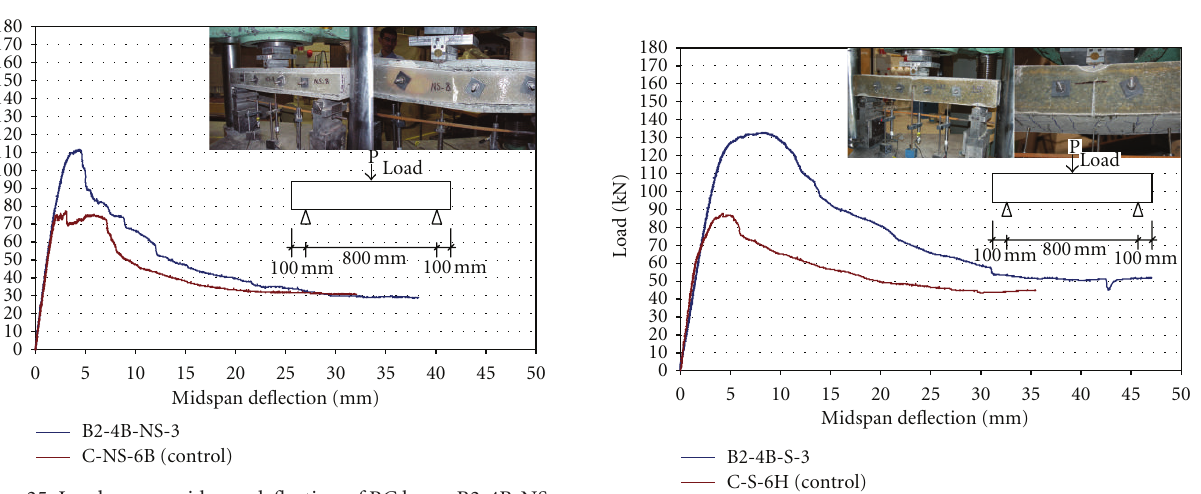
Figure 28: Load versus midspan deflection of RC beam